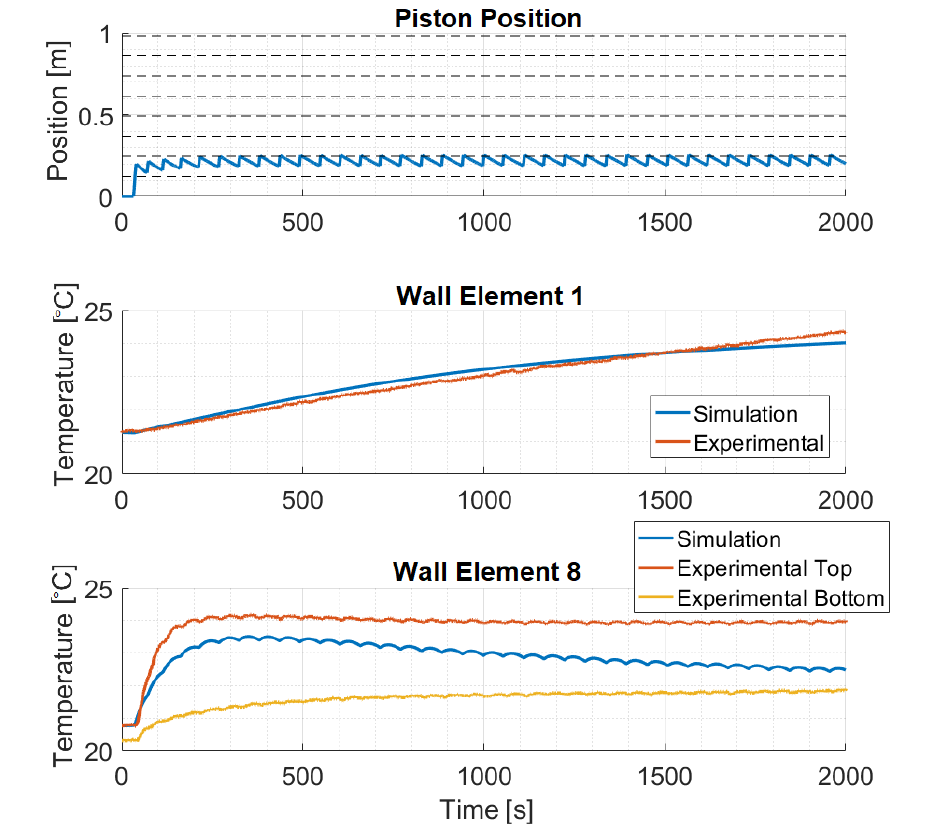
Figure 8. Simulated and experimental wall temperature of two wall elements. The upper sub-figure shows the piston position during the test. The dashed lines indicate the wall